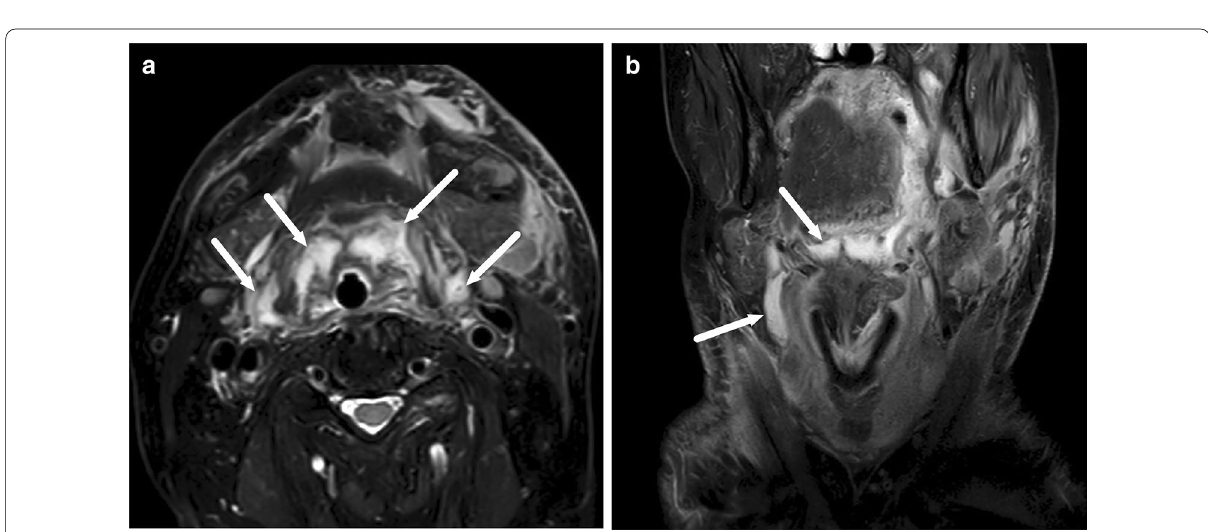
Fig. 29 A case of fatal necrotizing fasciitis following odontogenic infection. Axial ( a ) and coronal ( b ) fat-suppressed T2-weighted images show extensive soft tissue edema, fluid along fascial planes, and multi-space abscesses